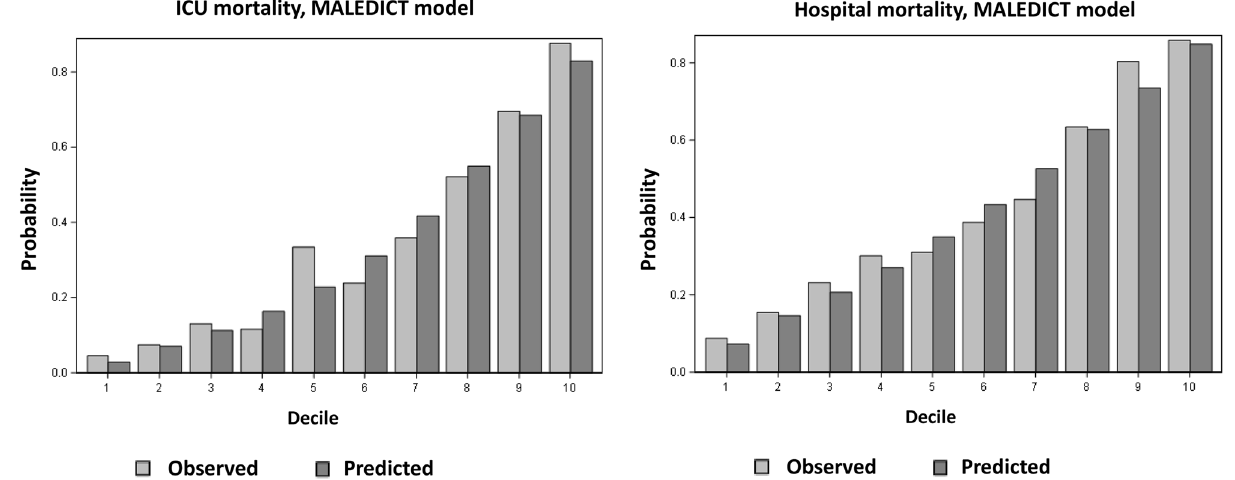
Figure 2. Calibration of the MALEDICT model for ICU and hospital mortality in the CRRT cohort. Average predicted probabilities of death and observed mortality according to decile of predicted probability of